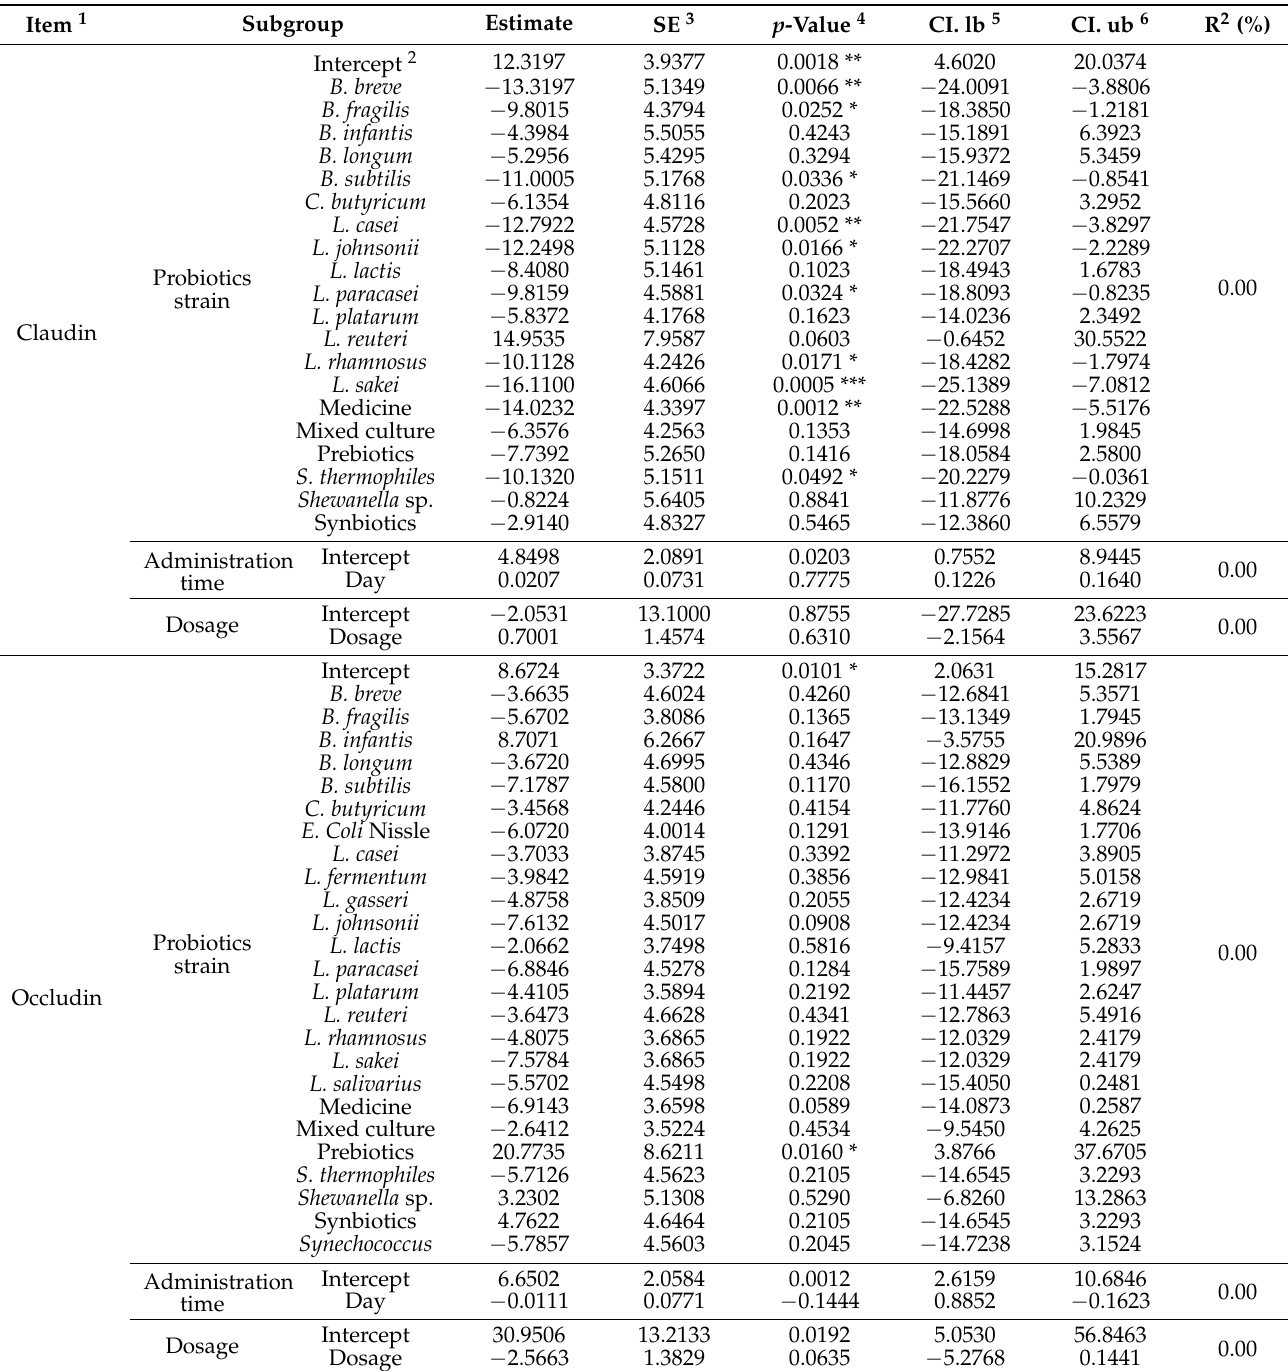
Table 3. Meta-ANOVA to analyze the effect of probiotics strain on the tight junction protein expression of intestinal tracts in the animal